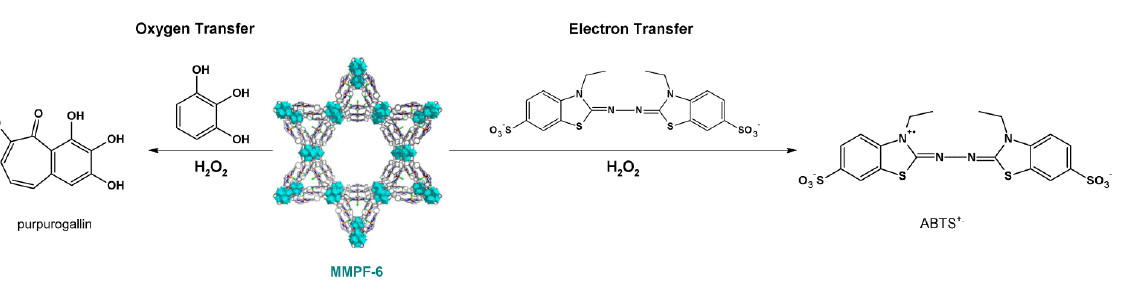
11. Oxidations catalyzed by MMPF-6 (middle): oxygen transfer to 1,2,3-trihydroxybenzene, to form purpurogallin (left), and electron transfer to ABTS, to give the pi-cation ABTS +· (right). Reprinted (adapted) with permission from [114]. Copyright (2012) American Chemical